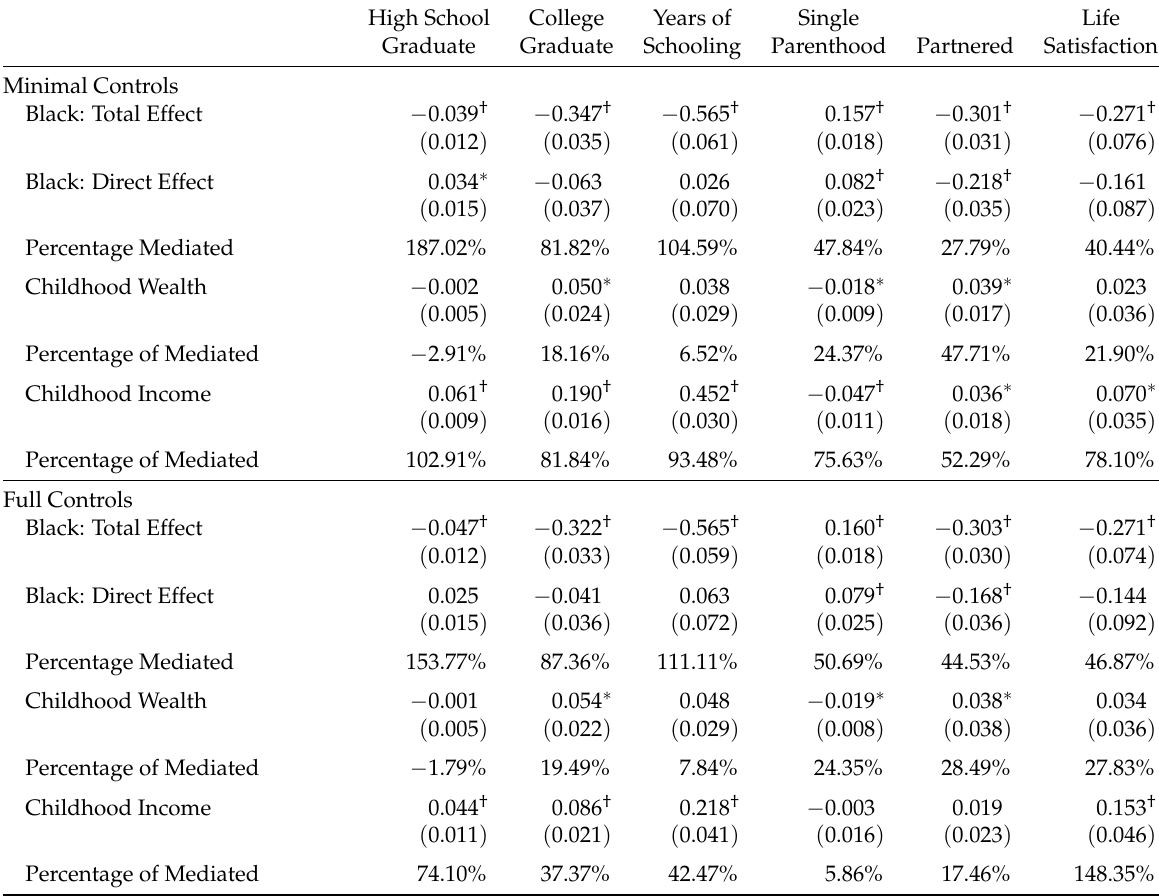
Table 2: Education, family, and life satisfaction outcomes: y -standardized coefficients or AMEs for being black and standardized coefficients or x -standardized AMEs for childhood wealth and